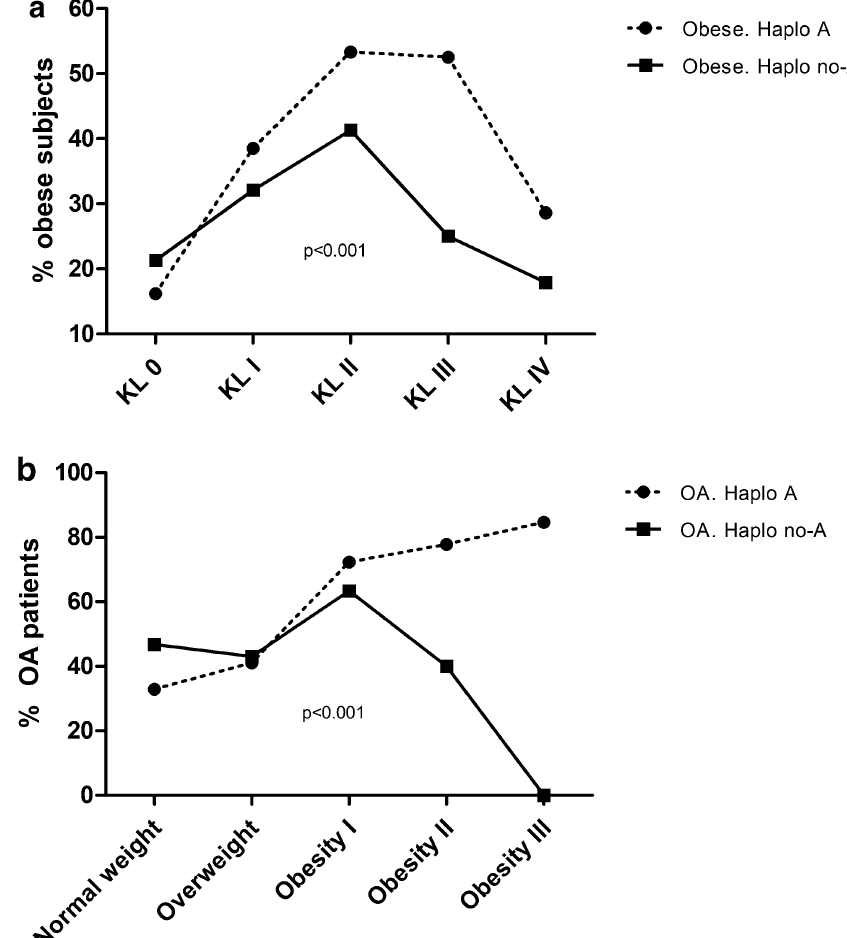
Figure 1. ( a ) Percentage of obese subjects on carriers and non-carriers of mtDNA haplogroup A according to radiological grade from KL 0 to KL IV. One-factor ANOVA test was used to compare the estimated probability of presenting obesity according to KL grade between mtDNA haplogroup A and non-haplogroup A carriers. ( b ) Percentage of OA patients on carriers and non-carriers of mtDNA haplogroup A according to degrees of obesity (normal weight: < 24.9; overweight: 25–29.9; obesity type I: 30–34.9; obesity type II: 35–39.9; obesity type III ≥ 40). One-factor ANOVA test was used to compare the estimated probabilities of presenting OA according to degrees of obesity between mtDNA haplogroup A and non-haplogroup A